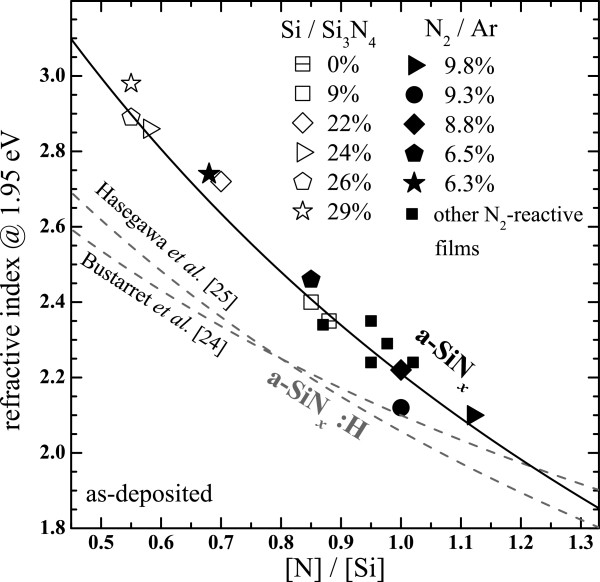
Evolution of the refractive index of SiNxthin films. The films were produced by the N2-reactive and the co-sputtering methods as a function of [N]/[Si] ratio. The data are compared with a new model (black curve) and with two models (dashed curves) but concerning hydrogenated films.